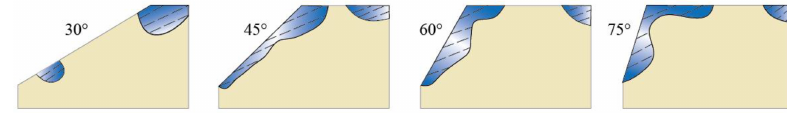
Figure 5. Development of tension zones in slopes of different gradients (Stacey, 1970; Zhang et al., 2009).